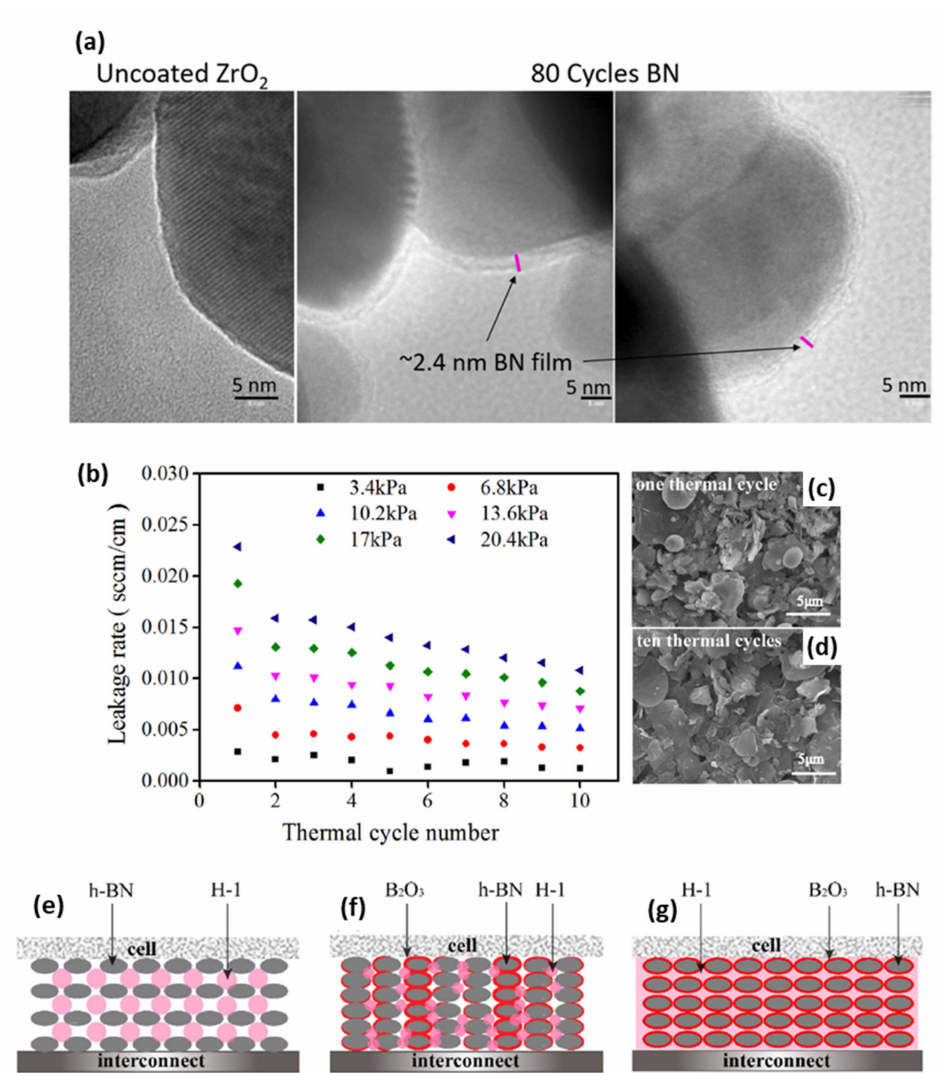
Figure 11. ( a ) TEM micrographs of uncoated ZrO 2 and ZrO 2 coated with ~2.5 nm amorphous BN film deposited using 80 ALD cycles. The leakage rates of BH60 seals after ten thermal cycles under a compressive load of 0.2 MPa and different input gas pressures at 750 ◦ C [160] (Reprinted with permission from Elsevier B.V, Copyright © 2021) ( b ) SEM micrographs of BH60 seal after ( c ) one thermal cycle and ( d ) 10 thermal cycles. ( e – g ) Schematic diagrams of the microstructure evolution of the BH60 seals overtime at 750 ◦ C [162] (Reprinted with permission from Elsevier